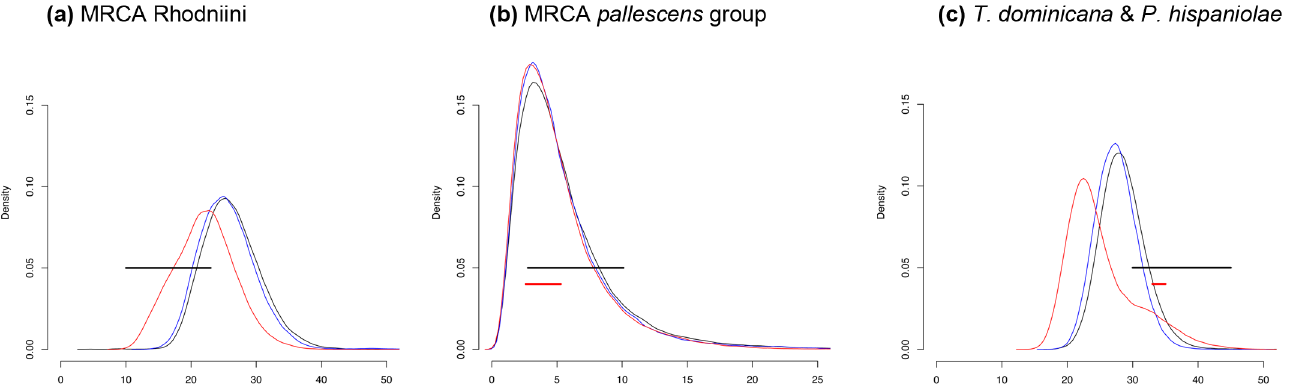
Fig 4. Other hypothesis testing. Events (black and red horizontal lines) plotted against posterior distribution (95% HPD) estimated for the nodes. Red distribution line refers to the estimates using one fossil calibration (B1); blue distribution line refers to the estimates using six fossil calibrations (B2); black distribution line refers to the estimates using seven fossil calibrations (B3); (a) Rhodniini MRCA – Pebas System; (b) pallescens group MRCA – Isthmus of Panama (red horizontal line) and last Andean uplift (Pliocene — black horizontal line); (c) ( spinolai clade + geniculatus clade + rubrofasciata clade) estimated ages — Fossils Triatoma dominicana and Panstrongylus hispaniolae ages (black horizontal line) and GAARlandia land bridge (red horizontal